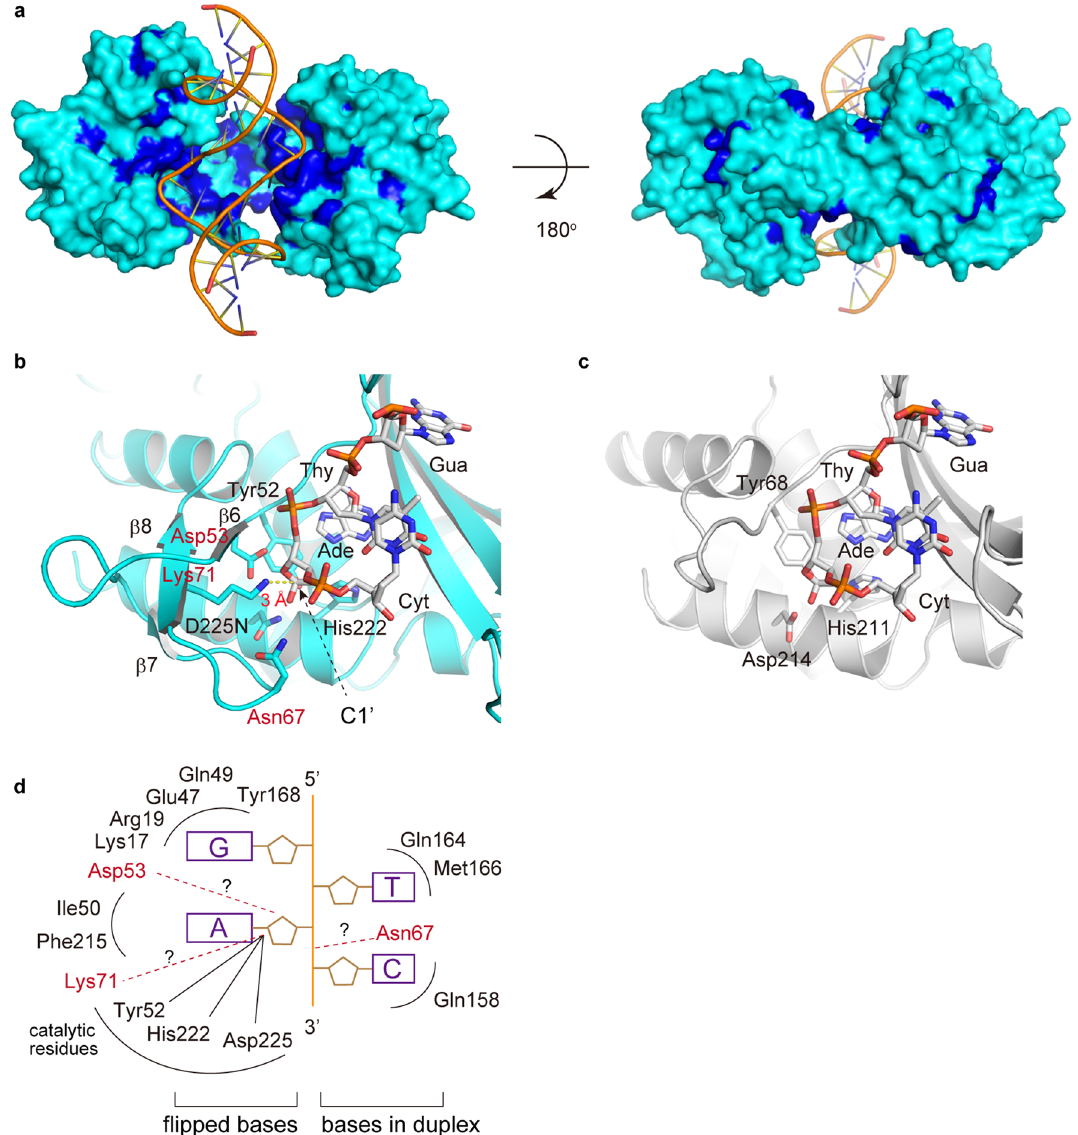
Figure 4. Active site structure. ( a ) R.CcoLI-DNA binding model. The model was prepared using the coordinates of R.CcoLI and the R.PabI-product DNA complex (PDB ID: 3WAZ). The sequence conservation of Fig. 1A is superposed on the molecular surface of R.CcoLI. The molecular surface of invariant residues is colored blue. The molecular surface of the other residues is colored cyan. The DNA model is shown as an orange cartoon. ( b ) DNA binding model of R.CcoLI around the active site. R.CcoLI is colored cyan. The DNA model of the sequence 5 ′ -GTAC-3 ′ is shown using a white stick model. The active site residues and residues near the catalytic site are shown by stick models. Residues in the characteristic antiparallel β-sheet region of R.CcoLI are labeled red. ( c ) Product DNA-binding structure of R.PabI around the active site. R.PabI is colored gray. ( d ) Plausible DNA recognition mechanism of R.CcoLI. The DNA backbone is shown as an orange line. R.CcoLI residues that are conserved in R.PabI are colored black. R.CcoLI-specific residues are colored red. DNA bases are colored